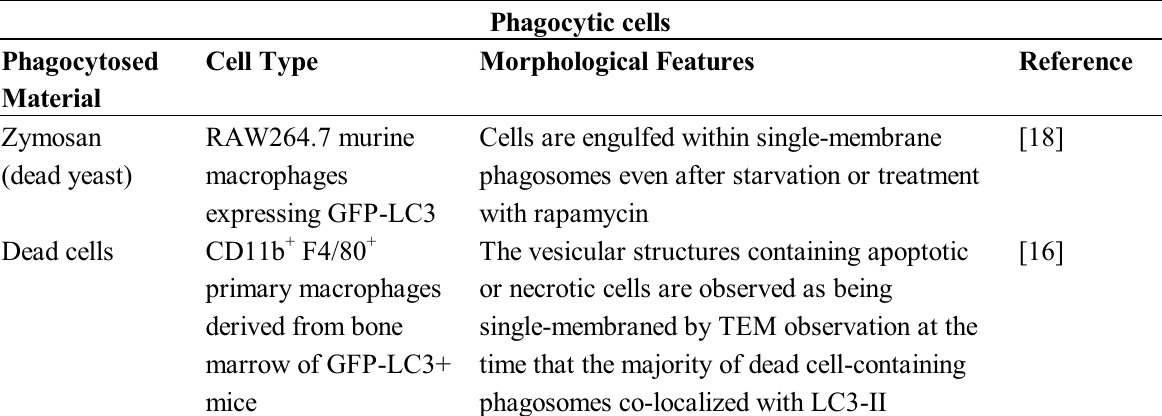
Table 2. Evidence for the occurrence of